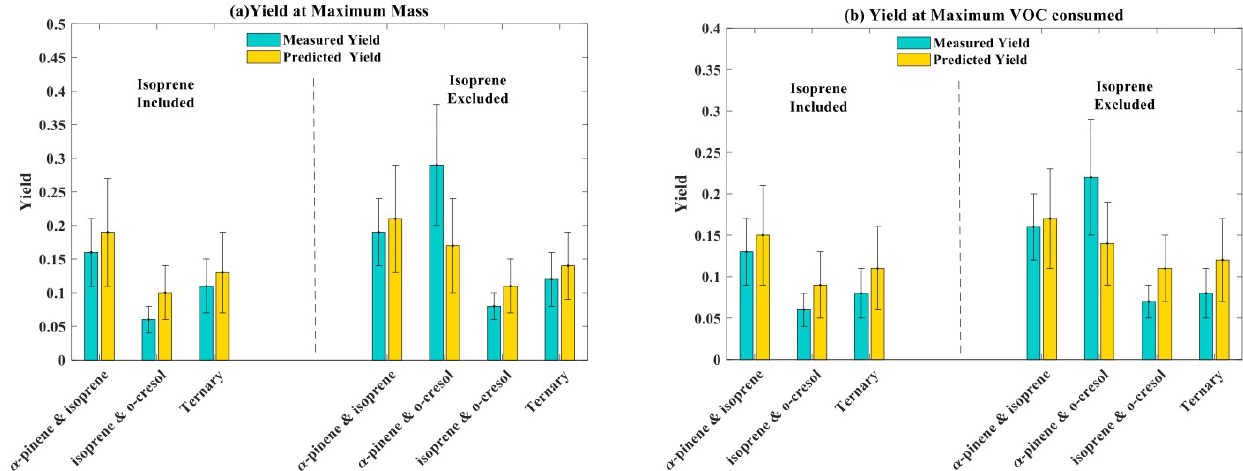
Figure 6. (a) Measured and predicted yield for all mixture precursor systems calculated at maximum particle mass. (b) Measured and predicted yield for all mixture precursor systems calculated at maximum VOC consumed. For mixtures containing isoprene, which had zero yield on the neutral seeds injected, the yields were calculated excluding the consumption of isoprene in the system, allowing them to be referenced to the mixtures without isoprene. Yield was calculated with the density of organic matter of 1.4µgm − 3 . The maximum mass used in the yield at maximum mass calculation is given in Table 1. The uncertainties in SOA particle mass yield were calculated by propagating ± 1 σ uncertainties of predicted SOA and measured